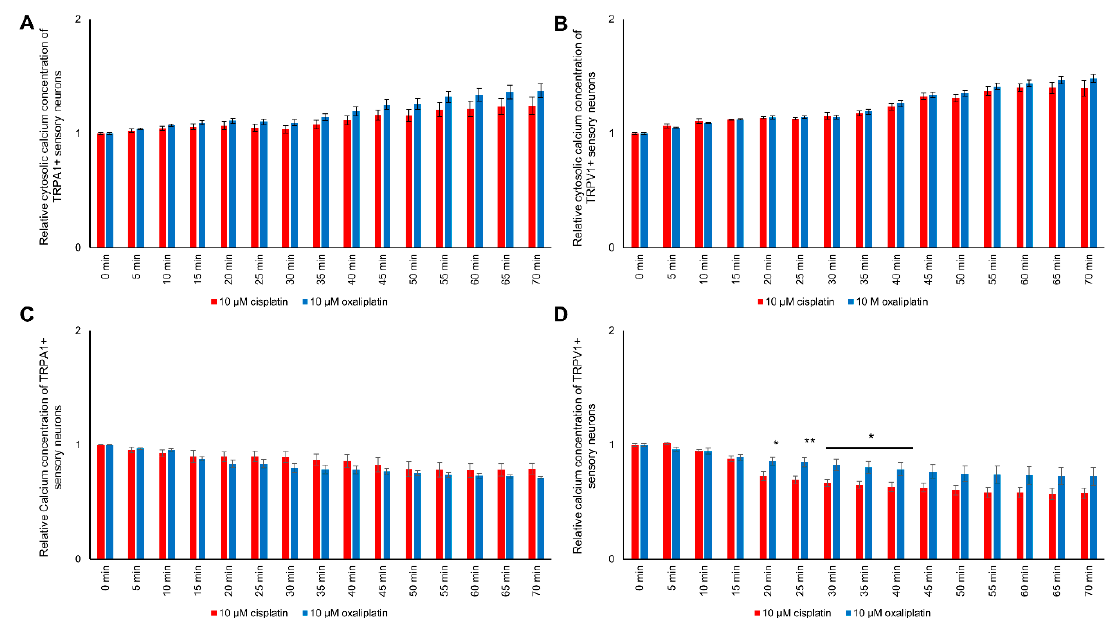
Figure 5. Relative cytosolic and mitochondrial calcium concentration during exposure to 10 µM cis- or oxaliplatin of TRPA1- or TRPV1-positive DRG neurons. ( A ) No differences in the cytosolic calcium concentration of TRPA1-positive DRG neurons after exposure to 10 µM cis- or oxaliplatin could be determined ( p > 0.05). ( B ) The cytosolic calcium of TRPV1-positive DRG neurons concentration during exposure to cis- or oxaliplatin showed no difference ( p > 0.05). ( C ) During exposure to 10 µM cis- or oxaliplatin, no difference in the mitochondrial calcium concentration of TRPA1-positive DRG neurons could be determined ( p > 0.05). ( D ) While exposing TRPV1-positive DRG neurons, differences between the two chemotherapeutics on the mitochondrial calcium concentration could be determined after 20 min. The mitochondrial calcium concentration of TRPV1-positive DRG neurons exposed to oxaliplatin was higher at 0.856 ± 0.033 compared to 0.727 ± 0.040 (* p < 0.05). The mitochondrial calcium concentration was higher for oxaliplatin-exposed TRPV1-positive DRG neurons until 0.786 ± 0.058 after 40 min (* p < 0.05). n = 6 cells per condition. * = significant effect between cis- and oxaliplatin, ** p < 0.01